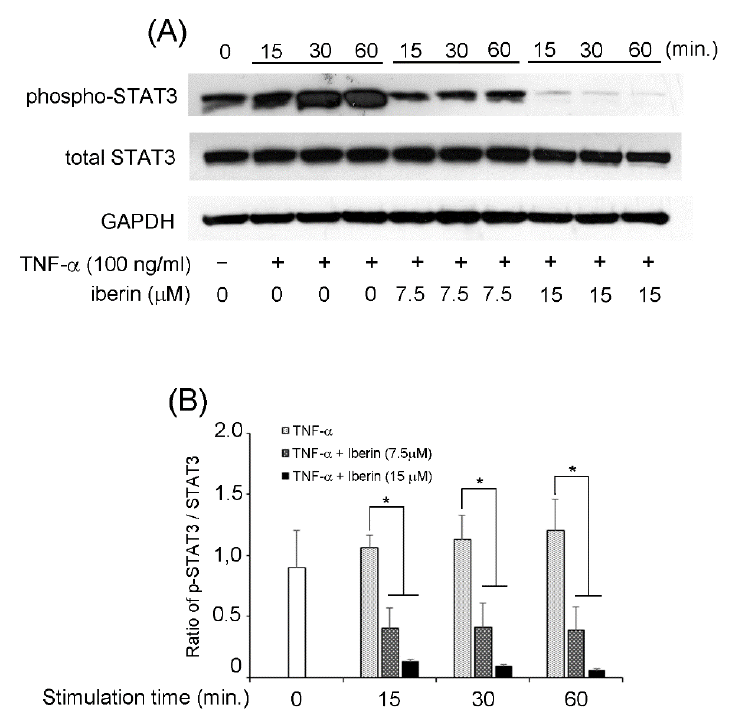
Figure 6. The effect of iberin treatment on the activation of a STAT3 pathway in TNF- α stimulated TR146 cells. TR146 cells were pretreated with iberin (7.5 or 15 µ M) for 1 h before being stimulated with TNF- α for 15, 30, or 60 min, and the phosphorylation of STAT3 was evaluated using Western immunoblotting. ( A ) Representative Western blot image of the expression of phospho-STAT3, total STAT3, and GAPDH. ( B ) Quantification of protein expression by densitometry analysis of Western blots. Data are expressed as the mean ± SD of three independent experiments. (* = p < 0.05).